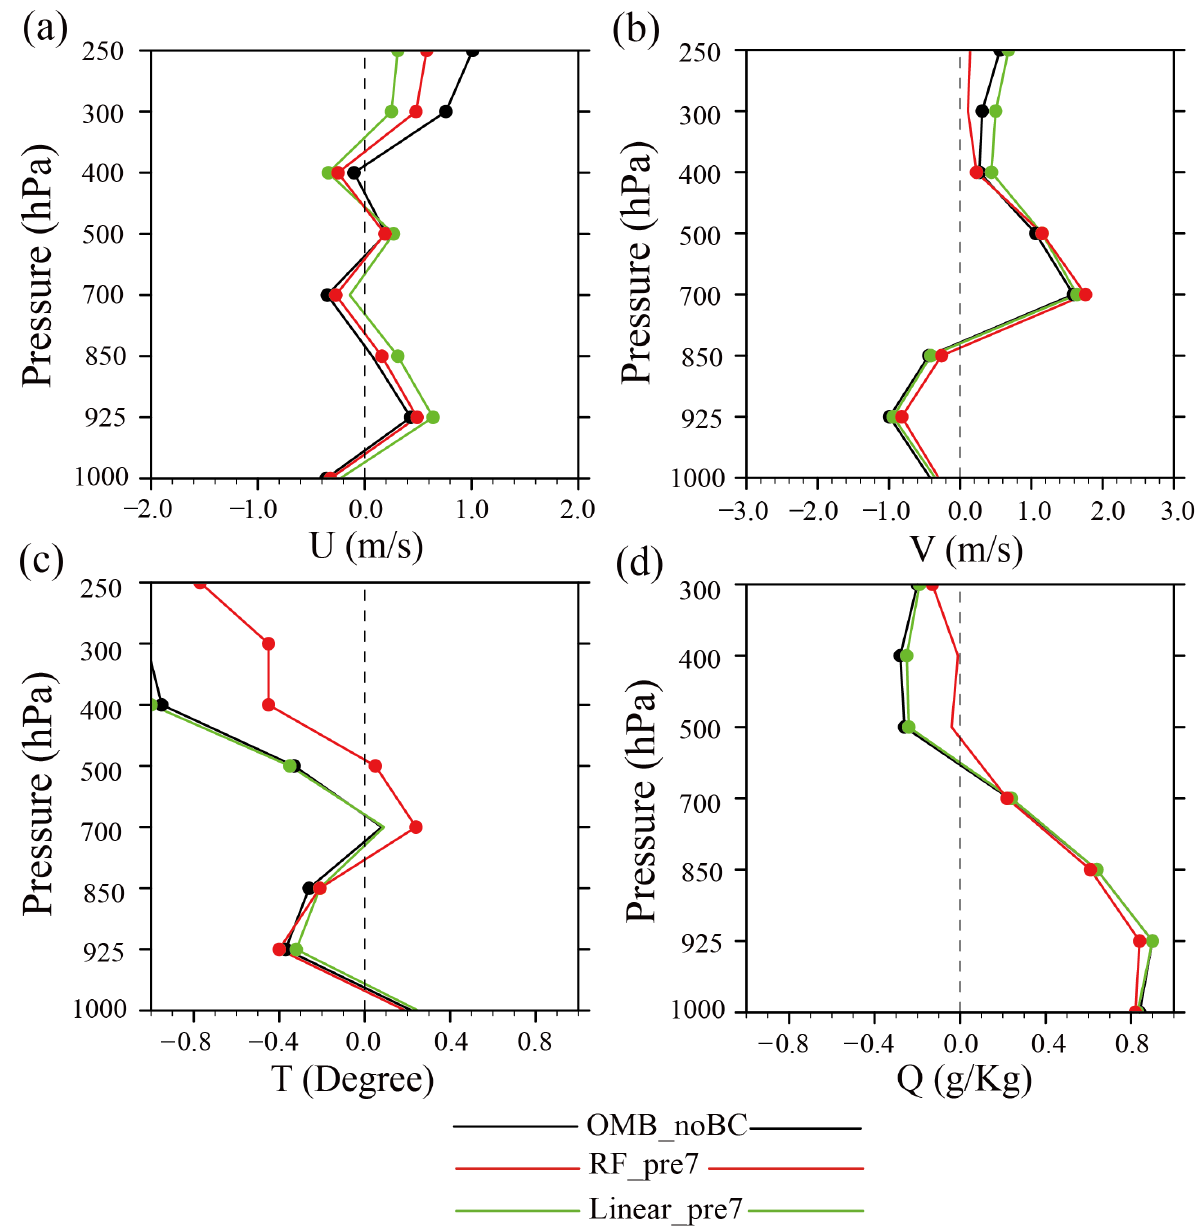
Figure 12. The bias vertical profiles of the analyses with the radiances of AGRI channels 9–10 from the OMB_noBC (black lines), RF_pre7 (red lines), and Linear_pre7 (green lines) experiments, respectively, verified against the sounding and surface synoptic observations for ( a ) U-wind, ( b ) V-wind, ( c ) temperature, and ( d ) specific humidity valid at 0600 UTC 20 July 2021. The marked dots show a significance level above 95%.